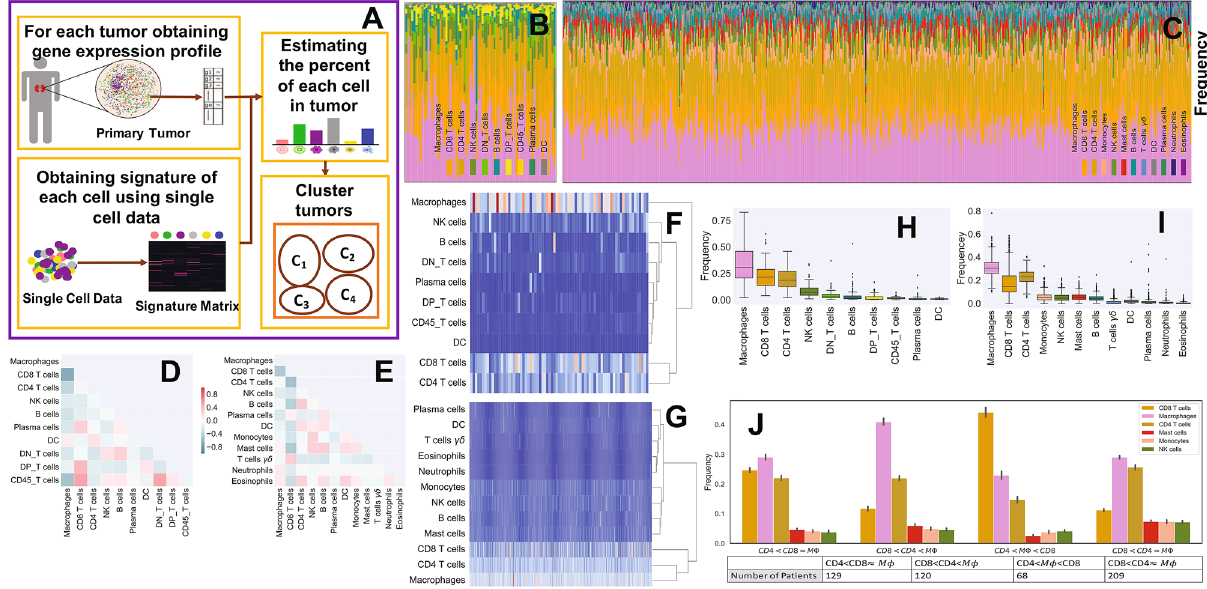
Figure 1. Immune pattern of ccRCC. Sub-figure ( A ) (created using PowerPoint v16.44) represents the algorithm of digital cytometry and clustering applied on TCGA data. Sub-figures ( B ) and ( C ), respectively show the estimated percentage of each immune cell by mass cytometry analysis of 73 ccRCC patients done by Chevrier et al. 14 ( B ) and digital cytometry on 526 TCGA ccRCC tumors ( C ). Sub-figures ( D ) and ( E ) indicate the correlation map of estimated immune cell frequencies in 73 ccRCC tumors ( D ) and TCGA ccRCC tumors ( E ), respectively. Sub-figures ( F ) and ( G ) show the cluster heat map of immune cell frequencies in 73 ccRCC tumors ( F ) and TCGA ccRCC tumors ( G ). Sub-figures ( H ) and ( I ) respectively show a box plot format of the immune cell percentages in 73 ccRCC tumors ( H ) and TCGA ccRCC tumors ( I ). Sub-figure ( J ) shows 4 distinct immune patterns of ccRCC tumors obtained by K-mean clustering of cell frequencies of TCGA ccRCC tumors. Sub-figures ( B )–( I ) have been created using TumorDecon 19 (https ://pypi.org/proje ct/Tumor Decon